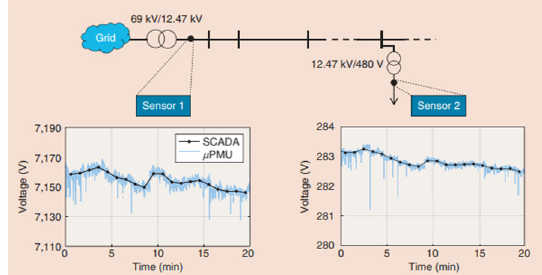
Fig. 2 μ -PMU v/s standard SCADA